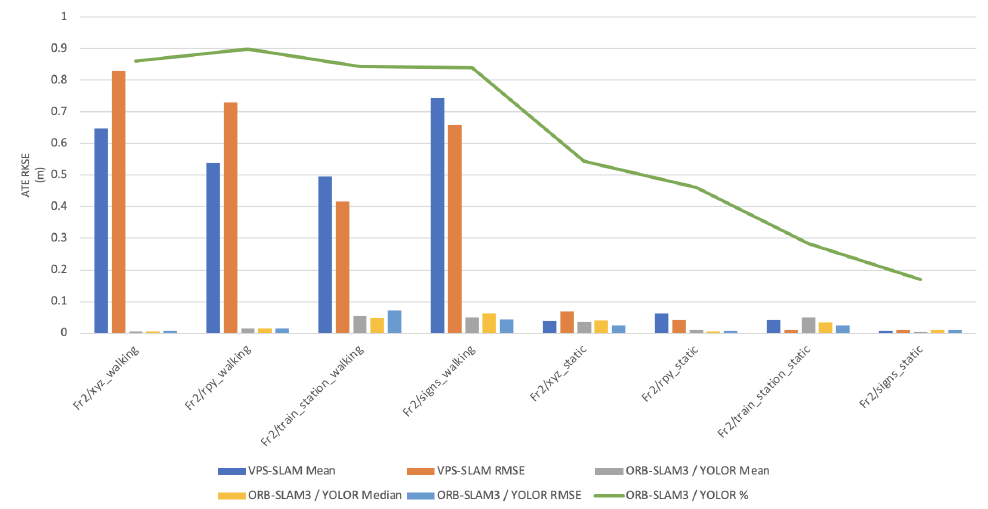
Figure 11. Absolute Trajectory Error (RMSE) distribution of VPS-SLAM and ORB-SLAM3/YOLOR.